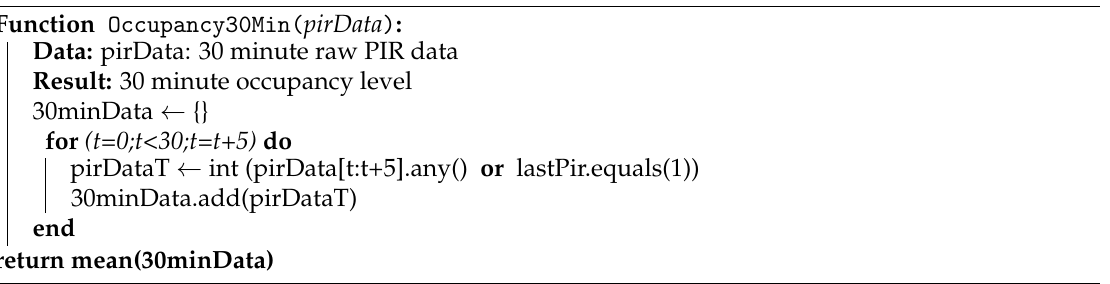
Algorithm 1 Algorithm to model 30 minute occupancy level